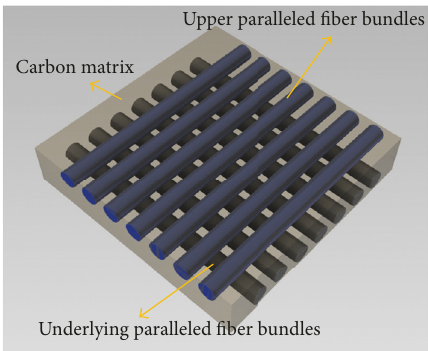
Figure 4: Schematic of paralleled carbon fibers and carbon matrix in C/C composites (Direction I).